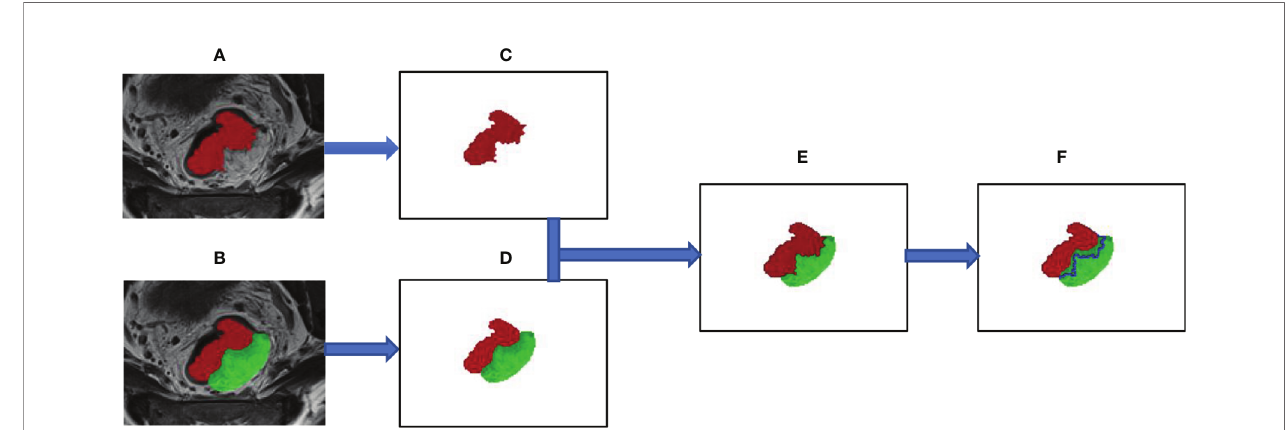
FIGURE 2 | The segmentation process of the region of interest for intratumor and peritumor. (A) The whole tumor was manually segmented on axial T2-weighted images and labeled as “ intratumor ” area (the red area). (B) Manually outline the area of the tumor bed (the green area), which is de fi ned as the mesorectal area that the tumor has invaded. (C) Show the outline of the entire tumor. (D – F) The edge link to the “ tumor bed ” of “ tumor ” was dilated by 5 mm and subtracted to obtain the “ peritumor ” tissues (the blue